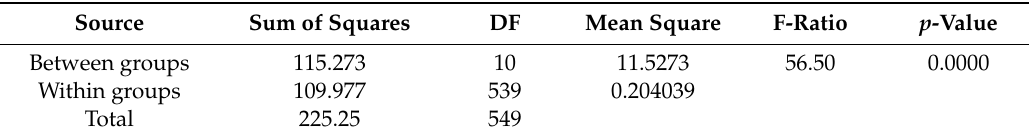
Table 3. Results of the Analysis of